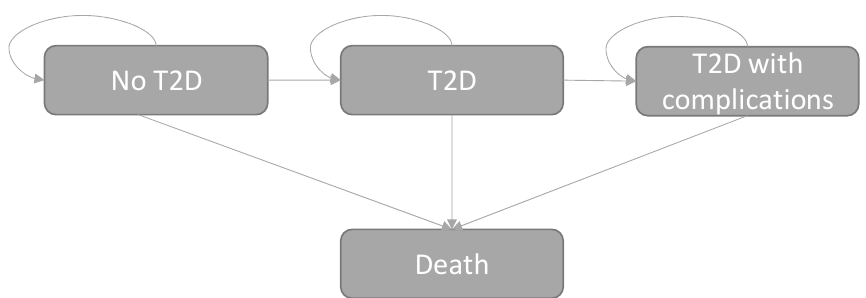
Figure 1. Schematic presentation of the applied Markov model showing the considered health states for the prevention of T2D. Arrows indicate possible transitions between health states in the model.